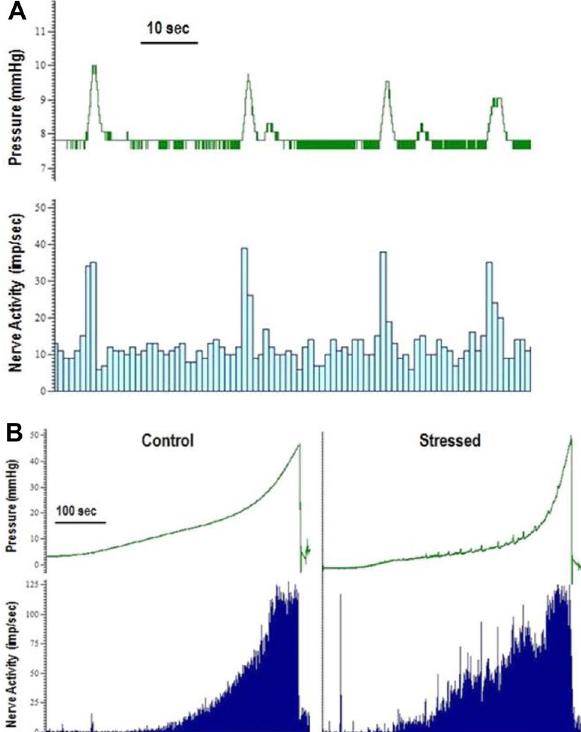
Figure 7. Typical pressure (mmHg) and nerve activity (imp/s) traces showing ( A ) the increase in nerve activity associated with the increase in pressure of phasic contractions in a stressed bladder during accommodation and ( B ) the phasic contractile activity of bladders during distension and the associated nerve activity from a control bladder (no phasic contractions) and a stressed bladder (presence of phasic contractions).